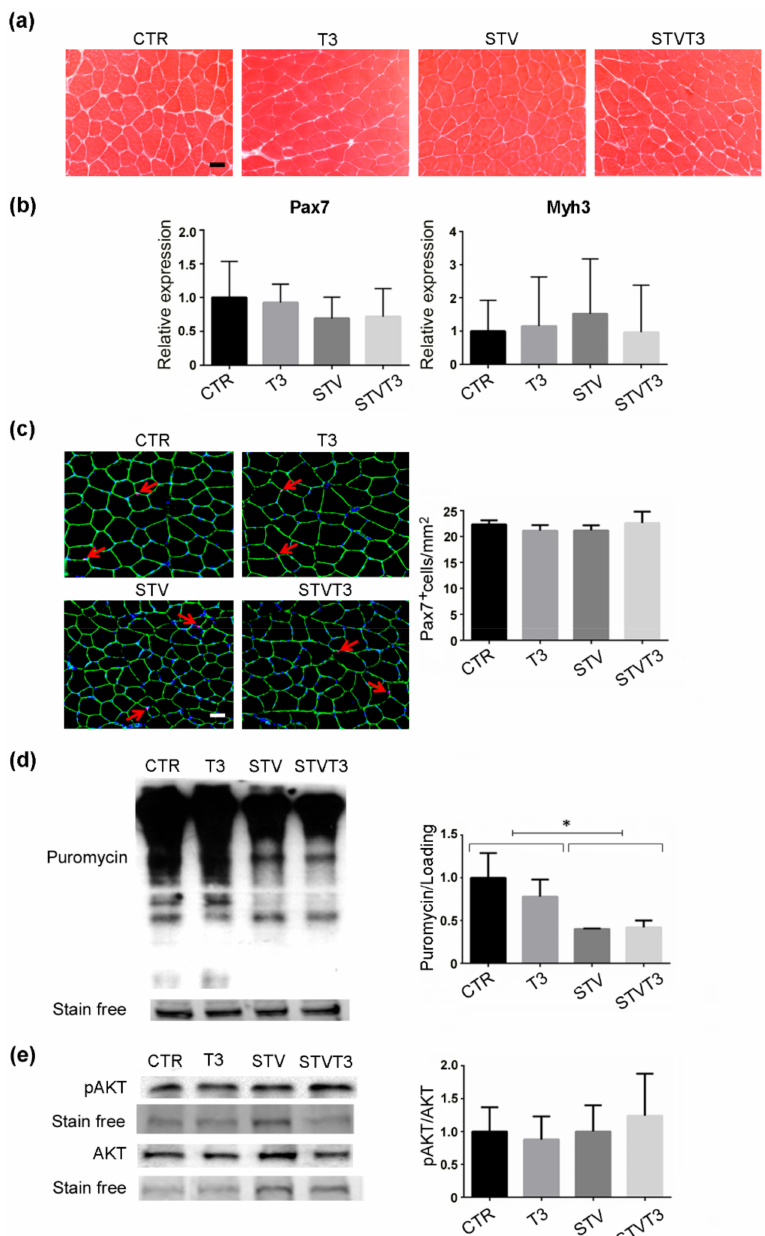
Figure 4. T3 does not increase skeletal muscle anabolism in skeletal muscle following starvation. ( a ) Representative histological sections of TA muscles, stained with hematoxylin and eosin, showing no evident sign of de novo muscle synthesis, 48 h after treatments. Scale bar = 20 µ m. ( b ) Pax7 and Myh3 mRNA expression, by real-time PCR, 24 hours after treatment. n = 6 mice per each condition. Data are presented as means ± SD. ( c ) Representative images of TA muscle stained for Pax7 (red arrows), laminin (green), and Hoechst (blue). Scale bar = 20 µ m. Quantification of the total number of Pax7 + cells / mm 2 . n = 3 mice per each condition. ( d ) SUnSET assay 48 h after treatments. Stain-free protein bands were used as a loading control. n = 4 mice per each condition. Data are presented as means ± SD; STV has a significant e ff ect (* p < 0.008) by two-way ANOVA. ( e ) Representative blot and relative densitometric analysis of phospho-Akt and Akt protein levels in TA, 24 h after treatments. Stain-free protein bands were used as the loading control. n = 4 mice per each condition. Data are presented as means ±